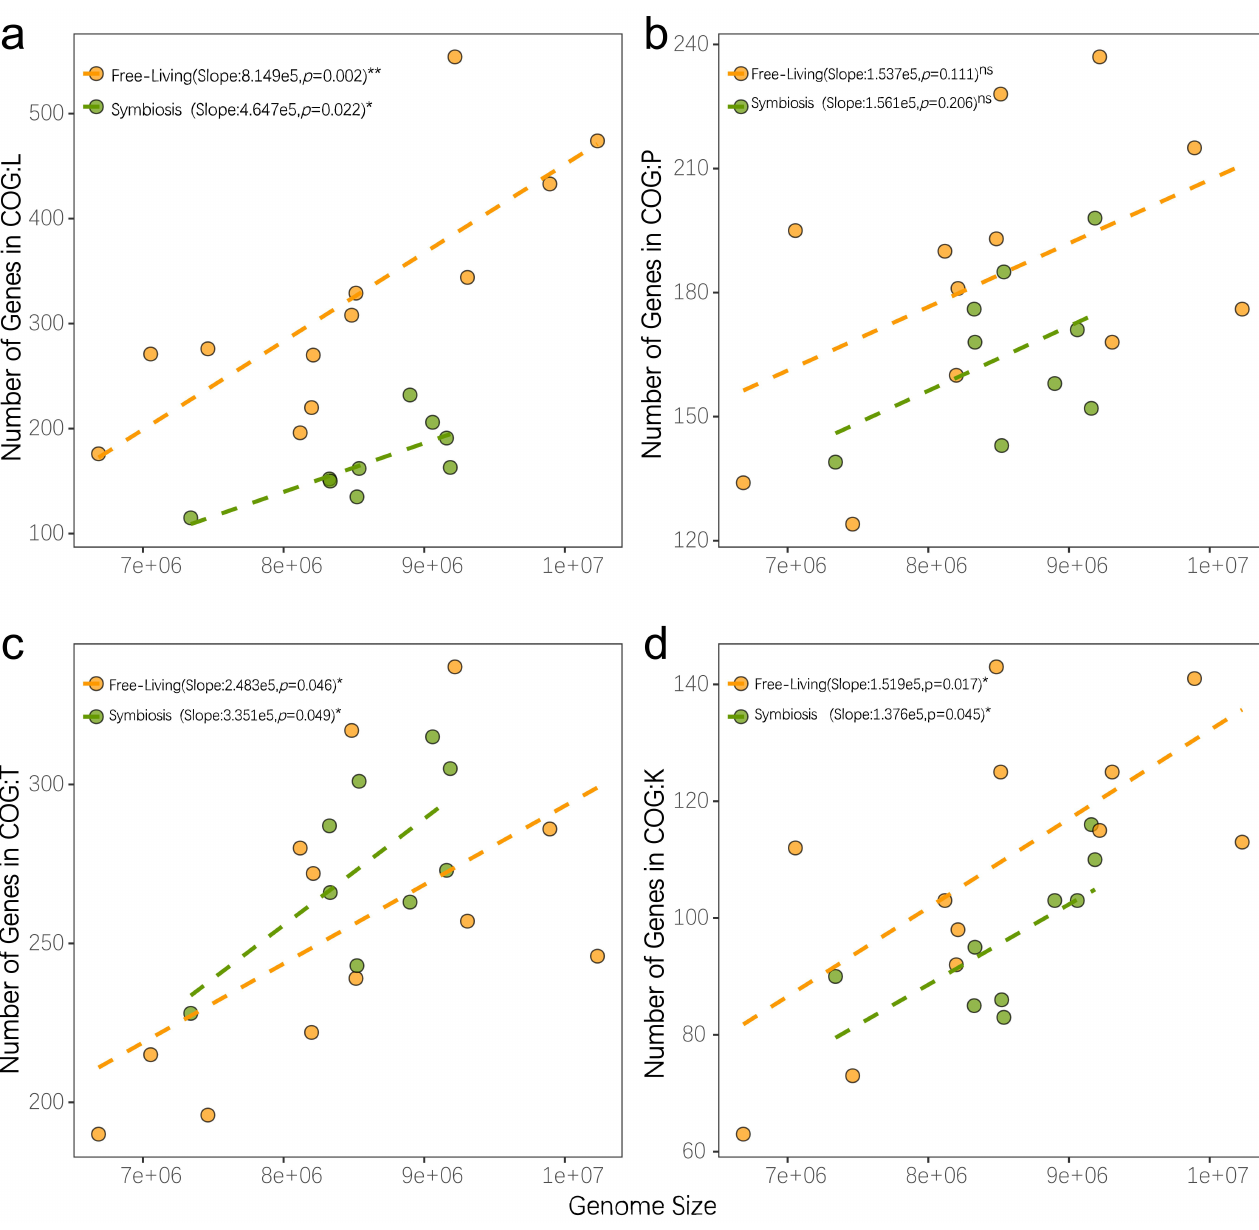
Table S2: Genome assembly and binning results, Table S3: Basic information of downloaded